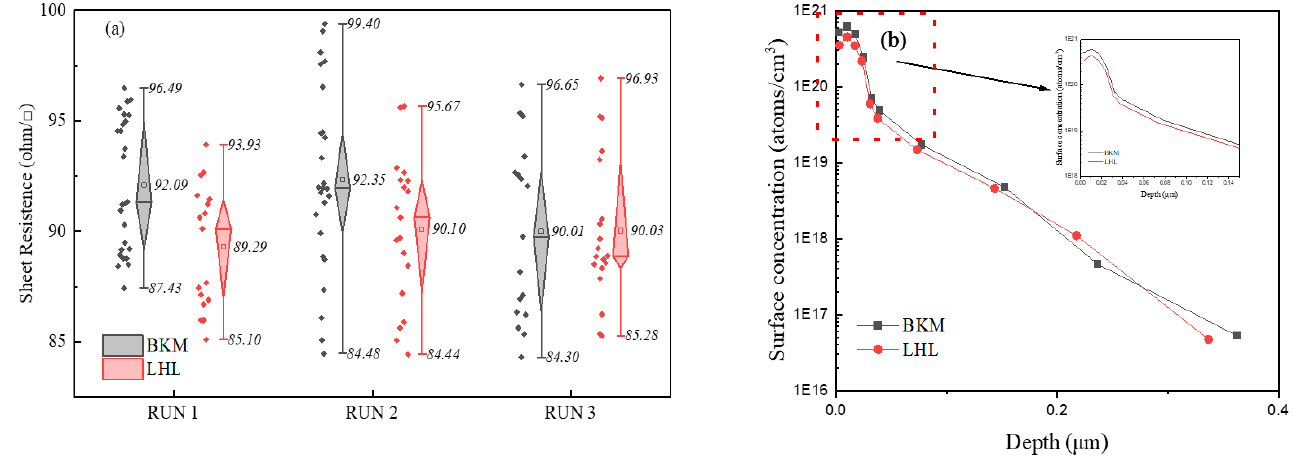
Figure 3. Sheet resistance box-plots of solar cells obtained from BKM and LHL diffusion processes ( a ), and the ECV profiles of P doping ( b ).